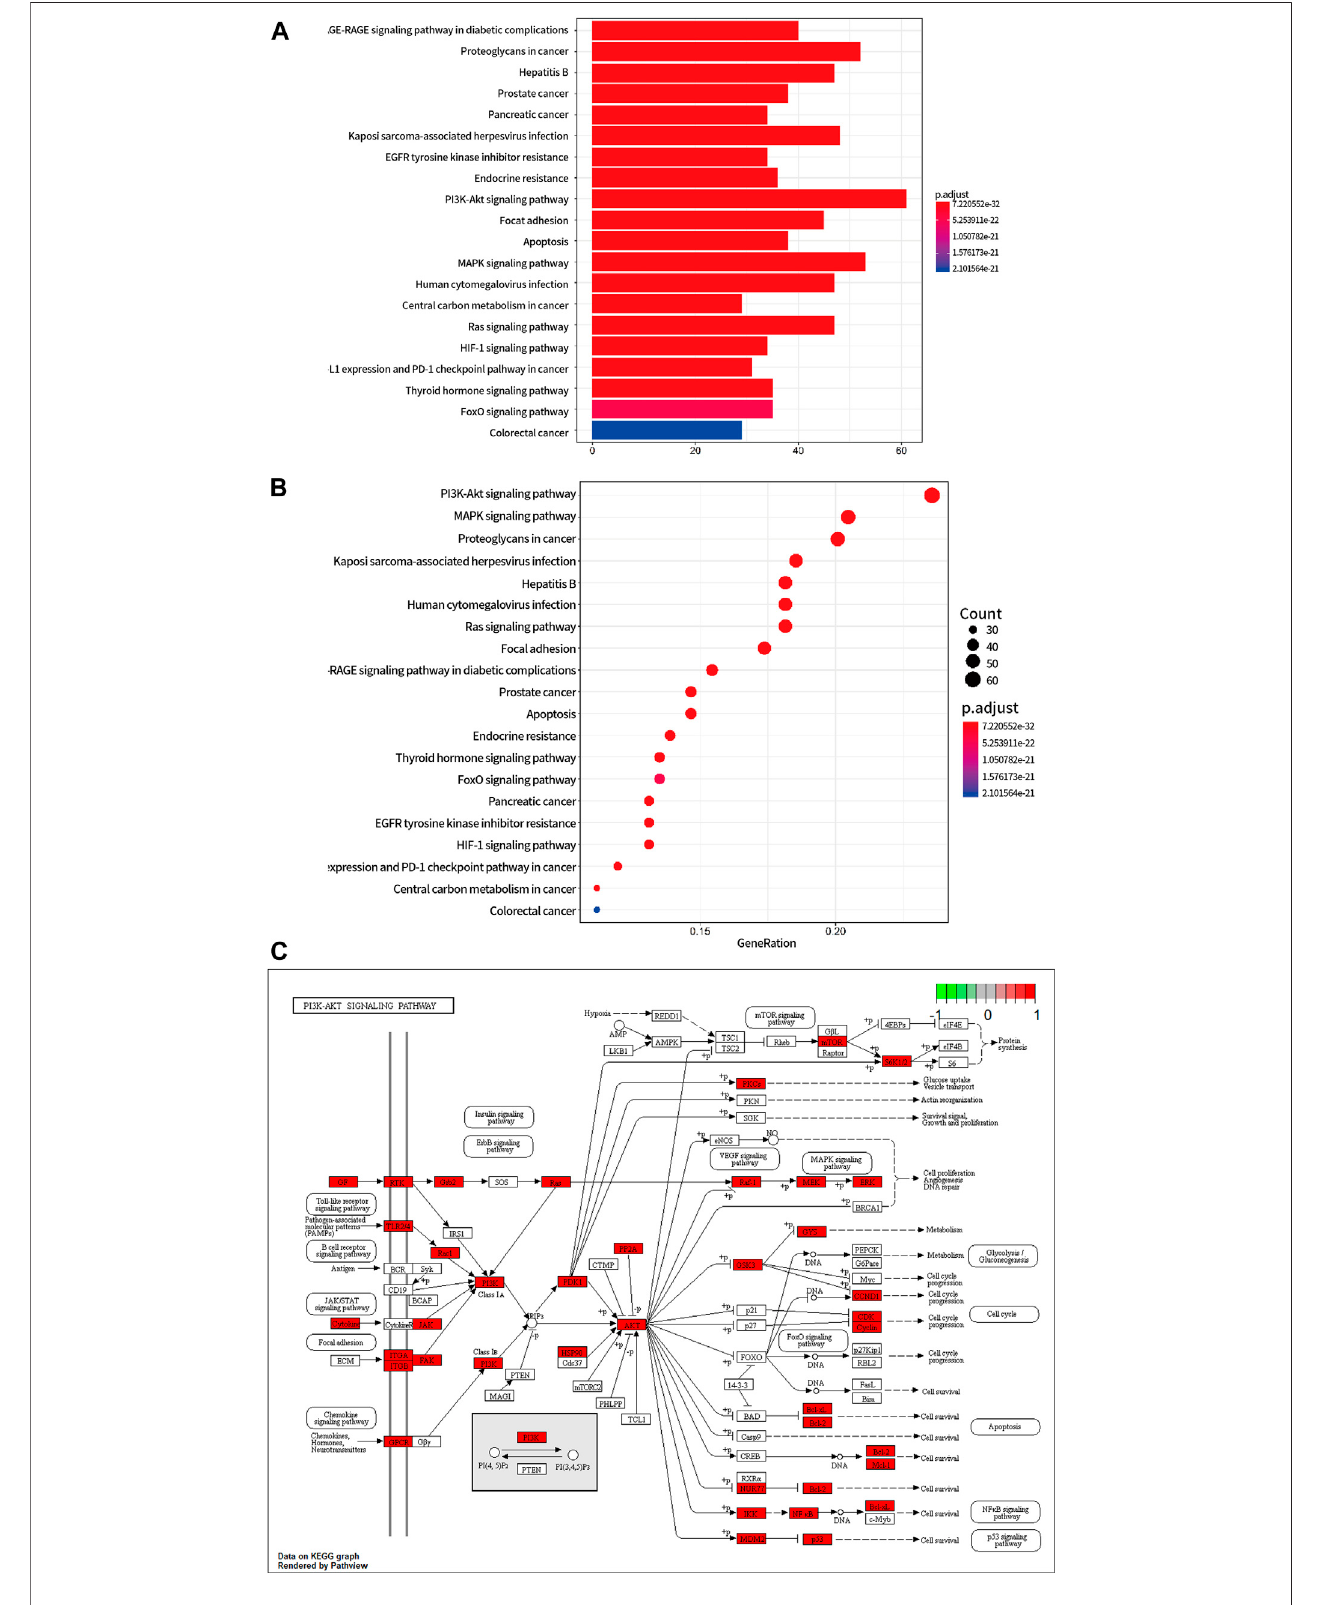
FIGURE6| Predictionofthecoresignalling pathway bywhich HJFregulatescardiac autophagy. (A) ,Bar graphofKEGGenrichmentanalysis; (B) ,Bubblechartof KEGG enrichment analysis; (C) , PI3K-AKT signalling pathway; the red box represents the target genes of HJF.